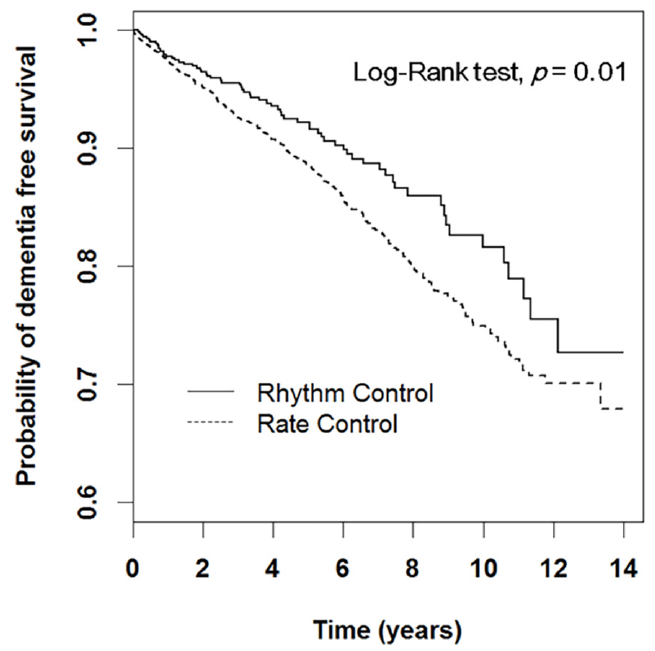
Figure 2. Kaplan–Meier survival curves for dementia outcomes in AF patients receiving rate and rhythm control strategies.